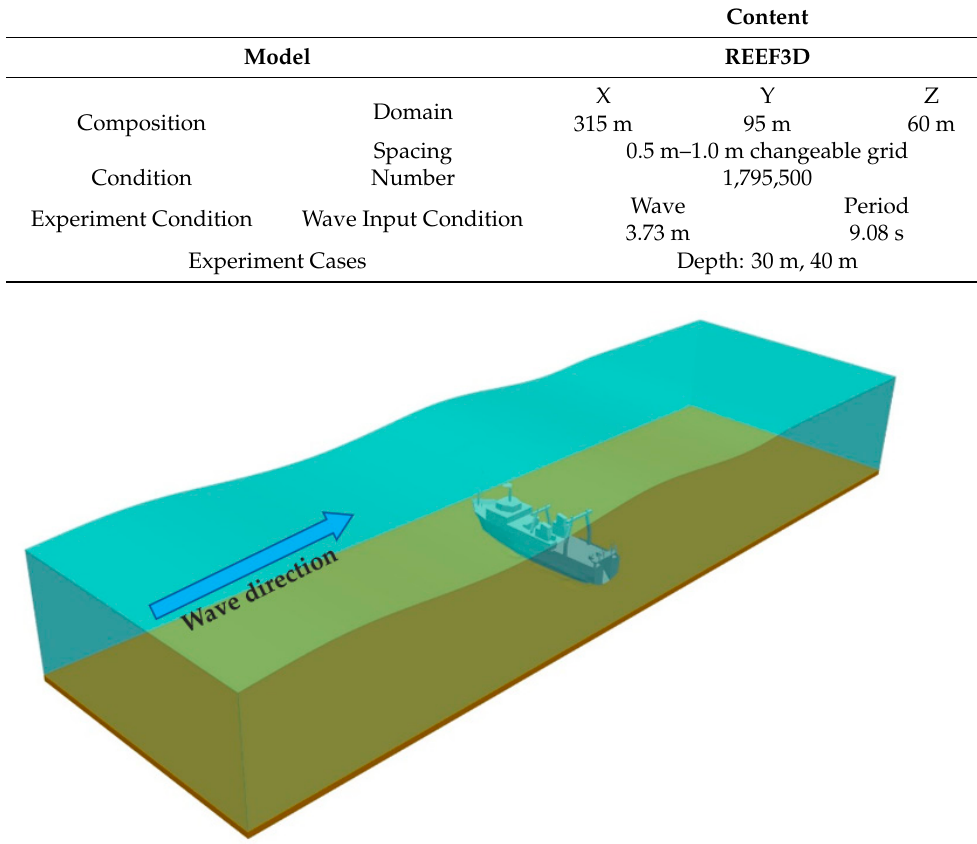
Figure 2. The numerical wave flume test using REEF3D model: schematic view.